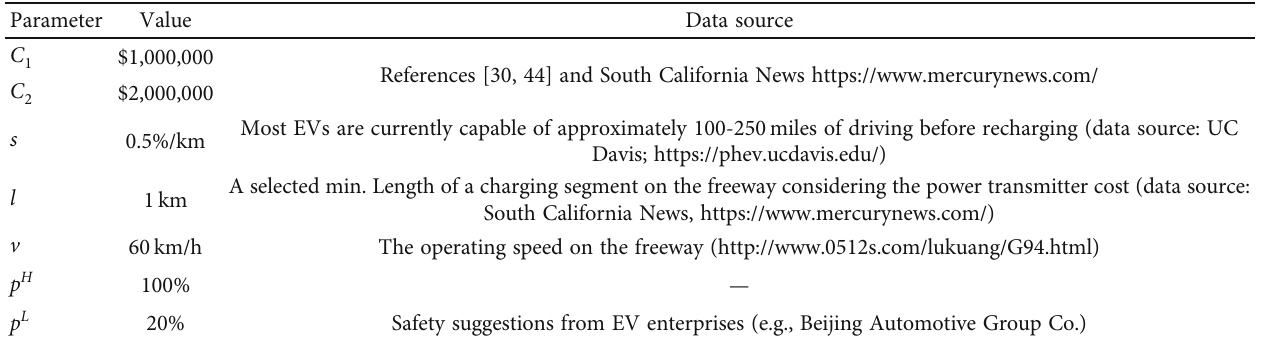
Figure 8: Toll station hourly travel demand. Table 3: Default parameter